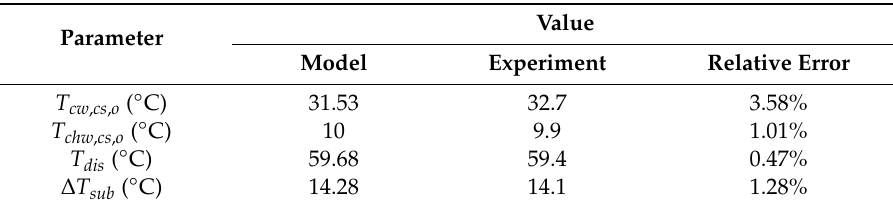
Table 1. Model validation of compression